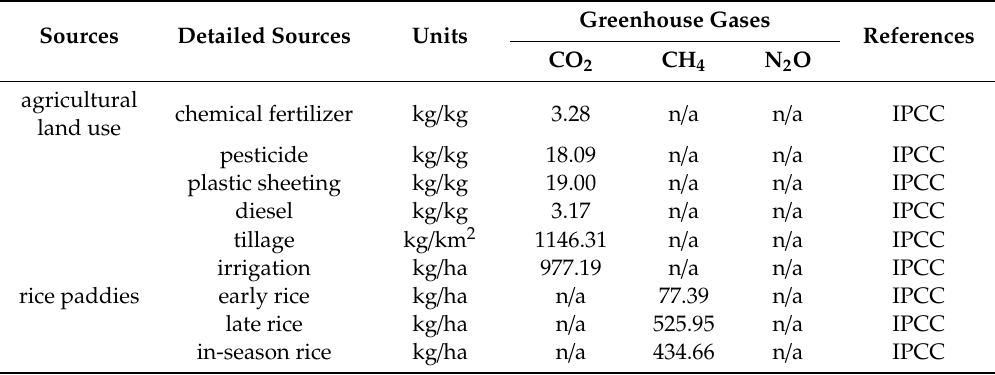
Table 1. Carbon emission sources and coefficients in the agricultural sector.